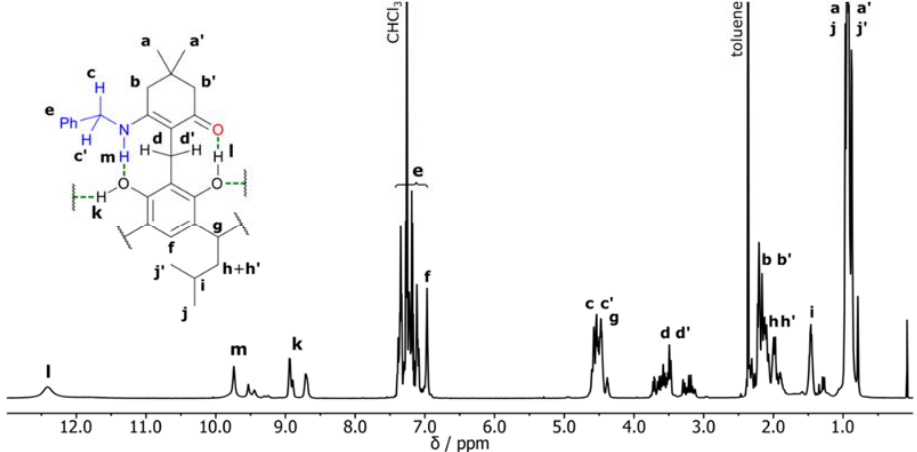
Figure 2. 1 H NMR spectrum of 4 (CDCl 3 , 298 K, 600 MHz).